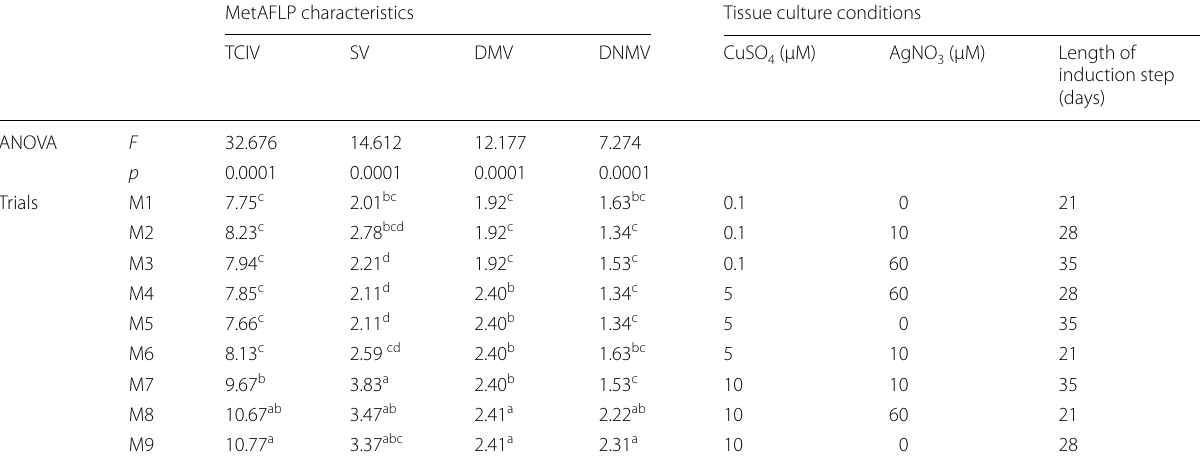
The TCIV, SV, DMV, and DNMV reflect tissue culture-induced variation, sequence variation, demethylation, and de novo methylation, respectively. The a, b, and c indicate Tukey’s HSD